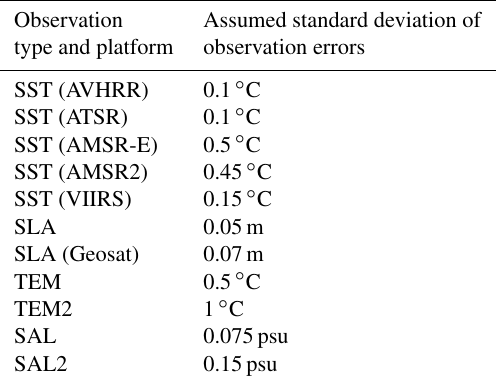
Table 1. Summary of observations and errors used when assimi- lated into BRAN. TEM (temperature) and SAL (salinity) include Argo, CTD, moorings, etc.; TEM2 and SAL2 includes XBT and marine